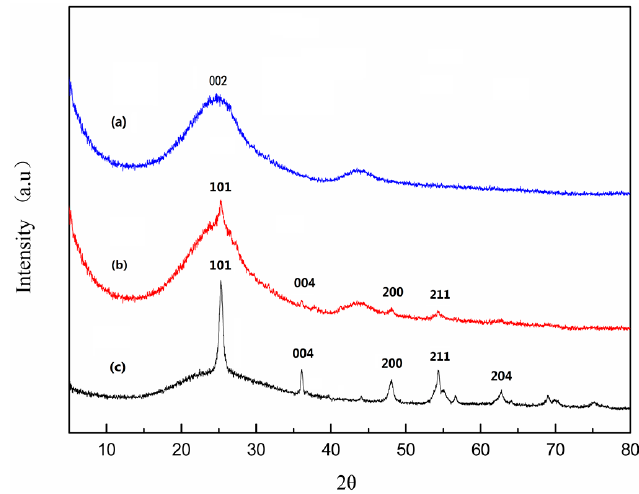
Figure 2. XRD patterns of the original carbon membrane ( a ); nano-TiO 2 /carbon membrane ( b ); and synthesized TiO 2 ( c ).